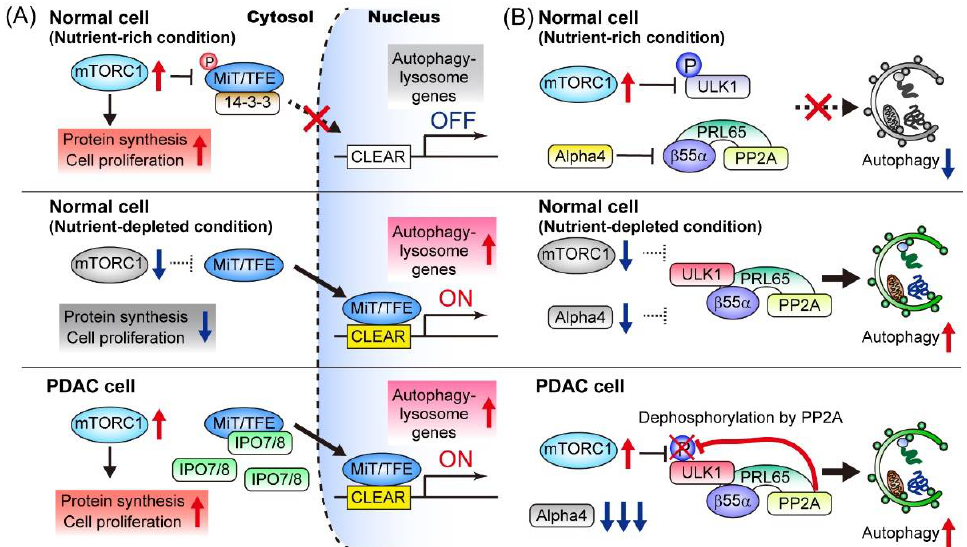
Figure 4. Mechanisms for the constitutive activation of autophagy in PDAC cells. ( A ) Under nutrient-rich condition, the mechanistic target of rapamycin complex 1 (mTORC1) phosphorylates microphthalmia (MiT)/transcription factor E (TFE), trapping these transcription factors in the cytosol. In PDAC cells, overexpression of IPO7 and IPO8 prevents mTORC1-mediated cytosolic retention of the MiT/TFE transcription factor [107]. ( B ) Under nutrient-rich condition, active mTORC1 phos- phorylates ULK1 at S637, thus blocking ULK1-mediated autophagy initiation. In PDAC cells, the expression of Alpha4, a negative regulator of PP2A phosphatase activity, is downregulated. Thus, the PP2A-PRL64-β55α complex actively dephosphorylates S637 on ULK1, thereby counteracting mTORC1-mediated autophagy inhibition [114]. Note that both mechanisms allow PDAC cells to employ mTORC1-driven anabolic processes and autophagy-mediated nutrient recycling. Figure 4 is adapted from reference [41], the use of which is licensed under a Creative Commons Attribution 4.0 International license https://creativecommons.org/licenses/by/4.0/. 3.2.6. Autophagy Is a Driver of Treatment Resistance Autophagy has been implicated in resistance [115–117]. Notably, recent studies have identified autophagy as a mechanism of resistance to inhibition of the mitogen-activated protein kinase (MAPK) pathway, a major downstream pathway of oncogenic KRAS. This was initially observed in a mouse model of PDAC, where genetic ablation of KRAS or pharmacological inhibition of the MAPK pathway led to rapid tumor shrinkage, while a small population of PDAC cells survived. Interestingly, surviving PDAC cells exhibit ele- vated autophagic flux, which is indispensable for their survival [118]. In line with this, several recent studies have demonstrated that autophagy flux is increased upon KRAS or MAPK inhibition in PDAC or other KRAS or RAF-driven cancers, and that the combined inhibition of autophagy and the MAPK pathway exerts potent anti-tumor activity in a synergistic manner [119–121]. Notably, a more recent study showed that combination therapy using the MAPK pathway inhibitor cobimetinib and the lysosomal inhibitor mef- loquine, but not either treatment alone, activates the STING/type I interferon pathway in PDAC cells, which in turn switches TAMs into a tumor-suppressive M1-like phenotype [122]. This immunological change is further augmented by the addition of an agonistic antibody to CD40, a costimulatory molecule that licenses and activates antigen-presenting cells upon ligand engagement [123], inducing a robust T-cell response [122]. Based on these promising preclinical findings, multiple clinical trials are currently testing the effi- cacy of a combined treatment with HCQ and MEK/ERK inhibitors (Table 1).